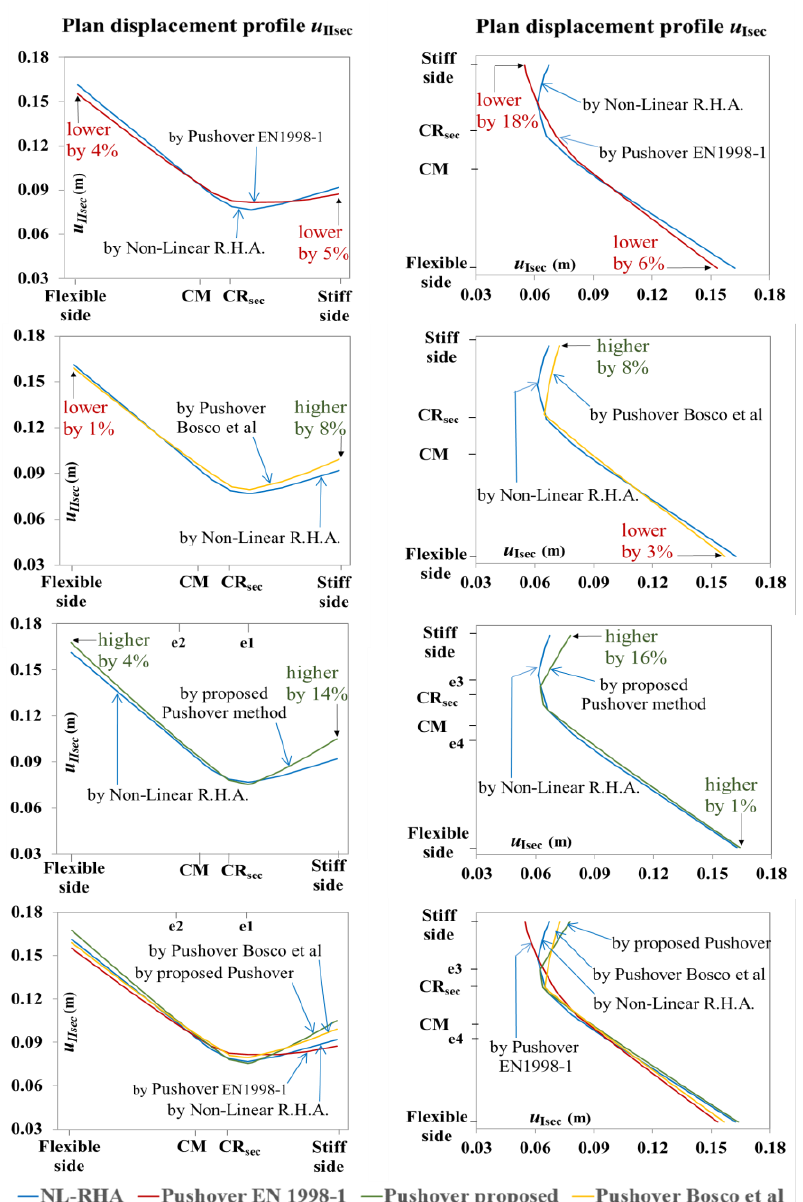
Fig. 12 . Plan inelastic displacement profile along the “Capable Near Collapse Principal Axes” 𝛪𝐼 and 𝛪 (right) resulted from the proposed Forced-Based pushover procedure. Comparison with the sec seismic demand (N-LRHA) and with EN 1998-1 (N2) and the “corrective eccentricity” (Bosco et al. 2017) pushover